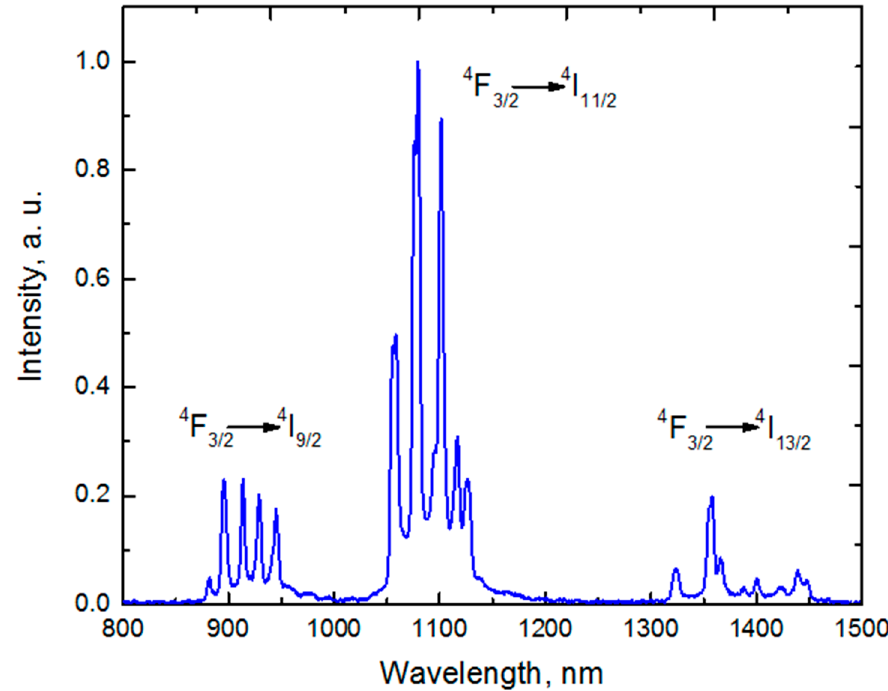
Figure 4. Fluorescence spectrum of Gd 2 O 3 :Nd 3+ .